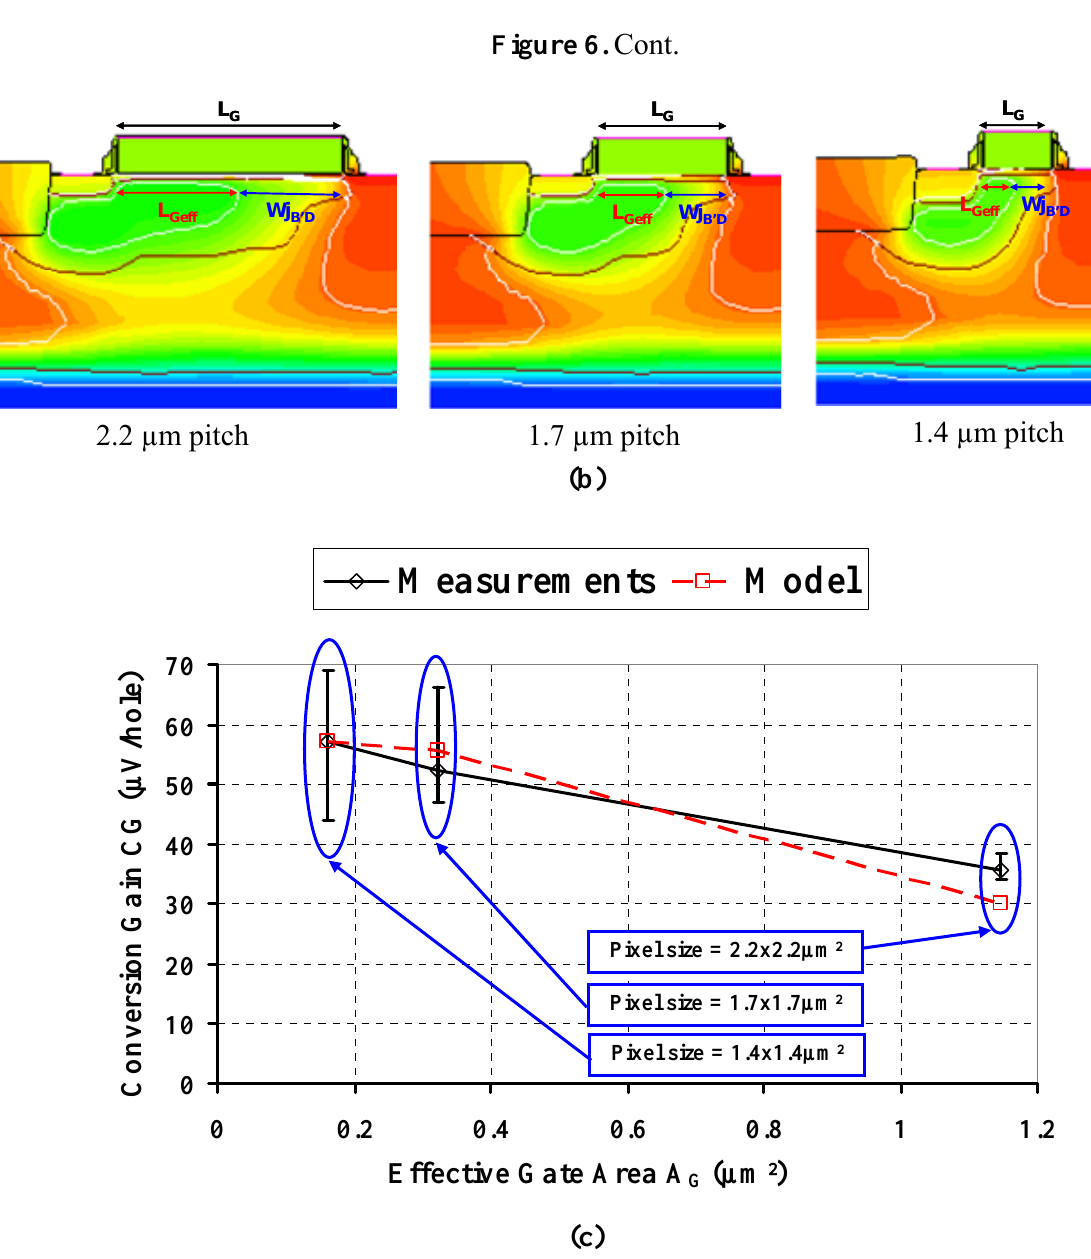
Figure 7 plots calculated and measured results on CG versus gate-oxide thickness: t and 100 Å respectively. Two configurations of oxidation process are compared: one is oxidation plus nitridation (gate oxide 1), and the other is oxidation only (gate oxide 2). It has been reported [10,